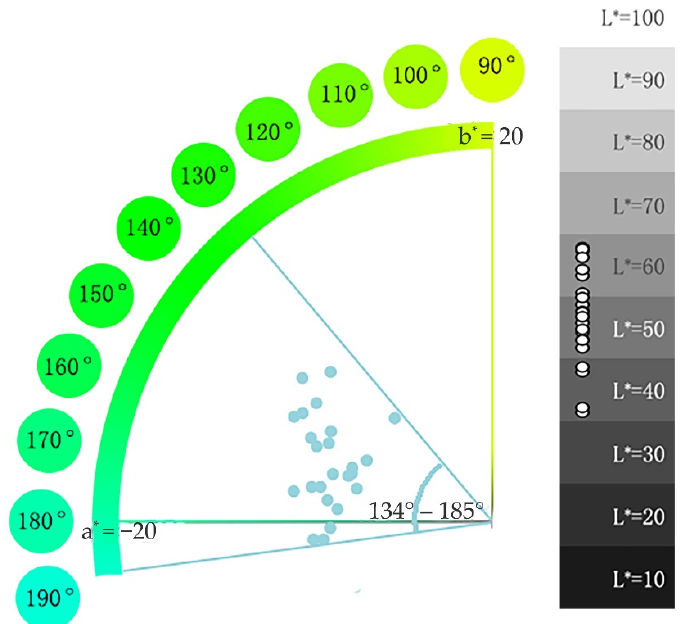
Figure 2. Colour distribution of samples in the CIELAB space. H ab ranges from 134° to 185°. L* ranges from 41 to 68.